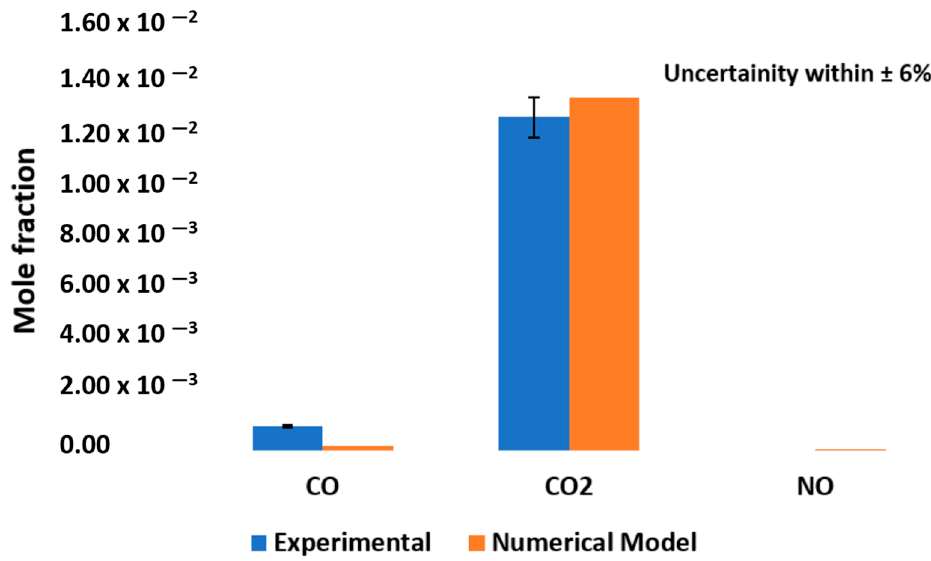
Figure 23. Comparison of numerical model and experimental data for mole fractions of CO, CO 2, and NO.